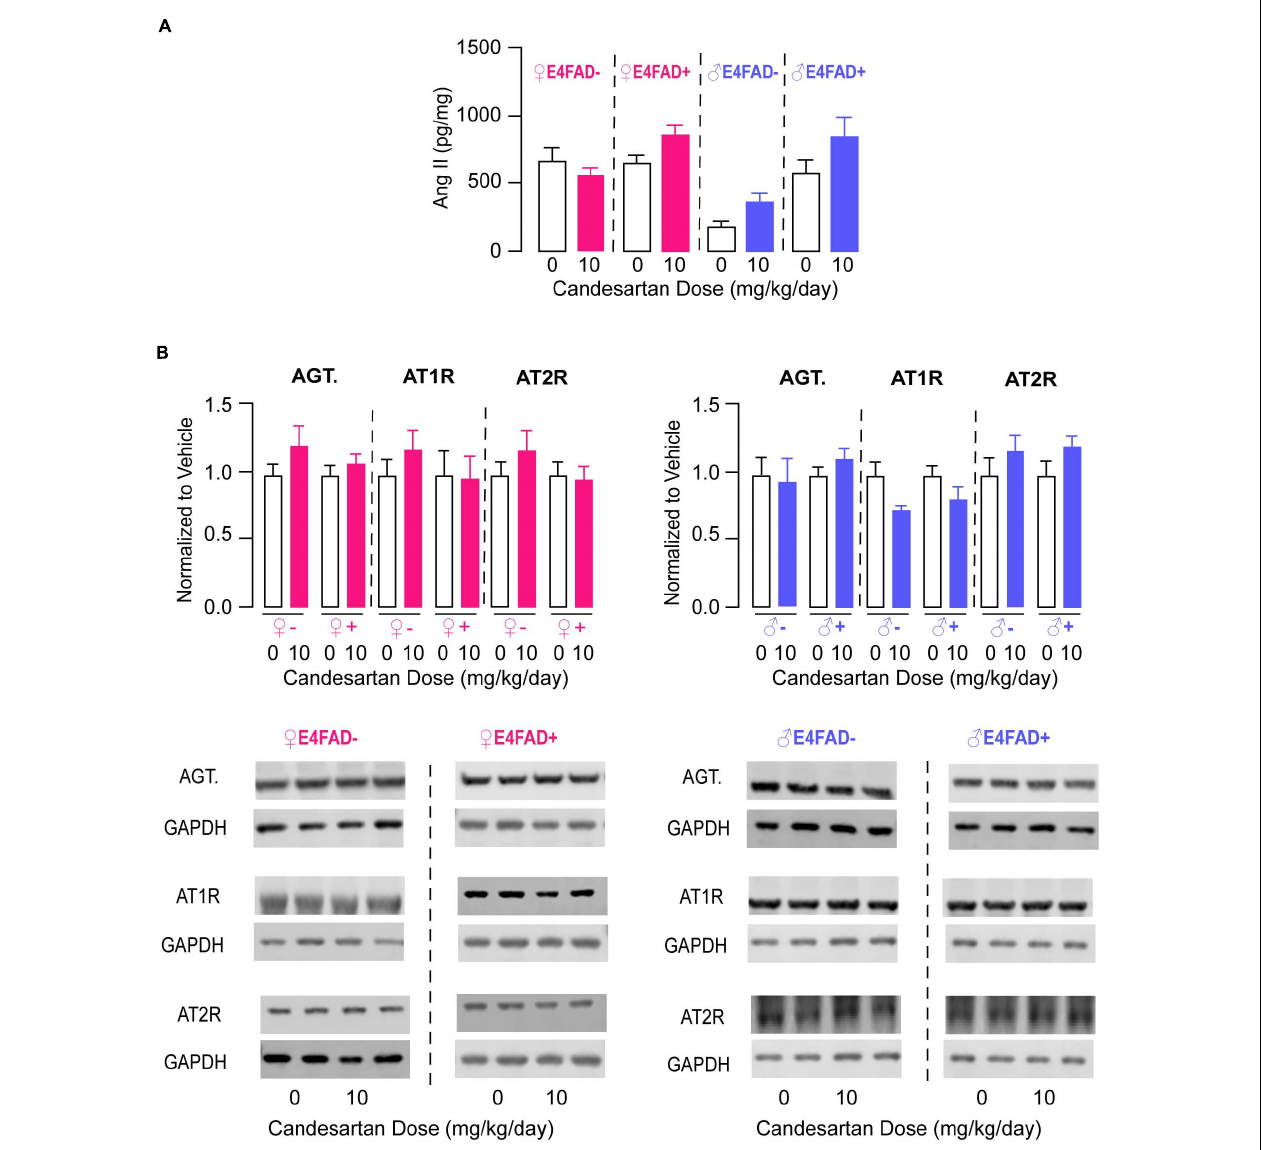
FIGURE 3 | High-dose candesartan treatment did not alter hippocampal angiotensin peptide and receptor levels compared to vehicle treatment in female and male E4FAD − and E4FAD + mice. In female and male E4FAD − and E4FAD + mice treated with 10 mg/kg/day candesartan (high dose), there were no differences in hippocampal levels of (A) angiotensin II when assessed by ELISA analysis [Female E4FAD − : t (18) = 0.15, p = 0.88. Female E4FAD + : t (17) = 1.85, p > 0.081. Male E4FAD − : t (8) = 2.23, p = 0.056. Male E4FAD + : t (8) = 1.53, p = 0.16] as well as (B) angiotensinogen, AT1 receptor, or AT2 receptor levels compared to vehicle when assessed by western blot analysis [Angiotensinogen: Female E4FAD − : t (17) = 1.30, p = 0.21. Female E4FAD + : t (22) = 0.81, p = 0.43. Male E4FAD − : t (10) = 0.27, p = 0.79. Male E4FAD + : t (9) = 1.19, p = 0.26. AT1: Female E4FAD − : t (18) = 1.00, p = 0.33. Female E4FAD + : t (21) = 0.09, p = 0.92. Male E4FAD − : t (10) = 2.28, p = 0.073. Male E4FAD + : t (9) = 1.44, p = 0.18. AT2: Female E4FAD − : t (18) = 1.00, p = 0.33. Female E4FAD + : t (22) = 0.21, p = 0.84. Male E4FAD − : t (10) = 1.04, p = 0.32. Male E4FAD + : t (9) = 1.45, p = 0.17]. In (B) quantification of each protein was normalized to GAPDH as a loading control and all data are expressed as a ratio to vehicle-treated mice. All data expressed as mean + / − SEM. p > 0.05 by Student’s t -test. See Supplementary Table 2 for details on n sizes.